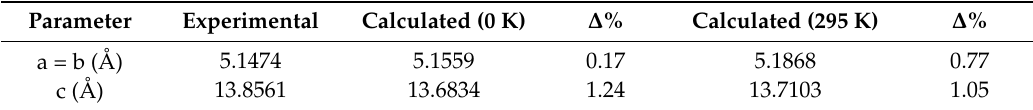
Table 2. Comparison of experimental [16] and calculated lattice parameters for LiNbO 3 .